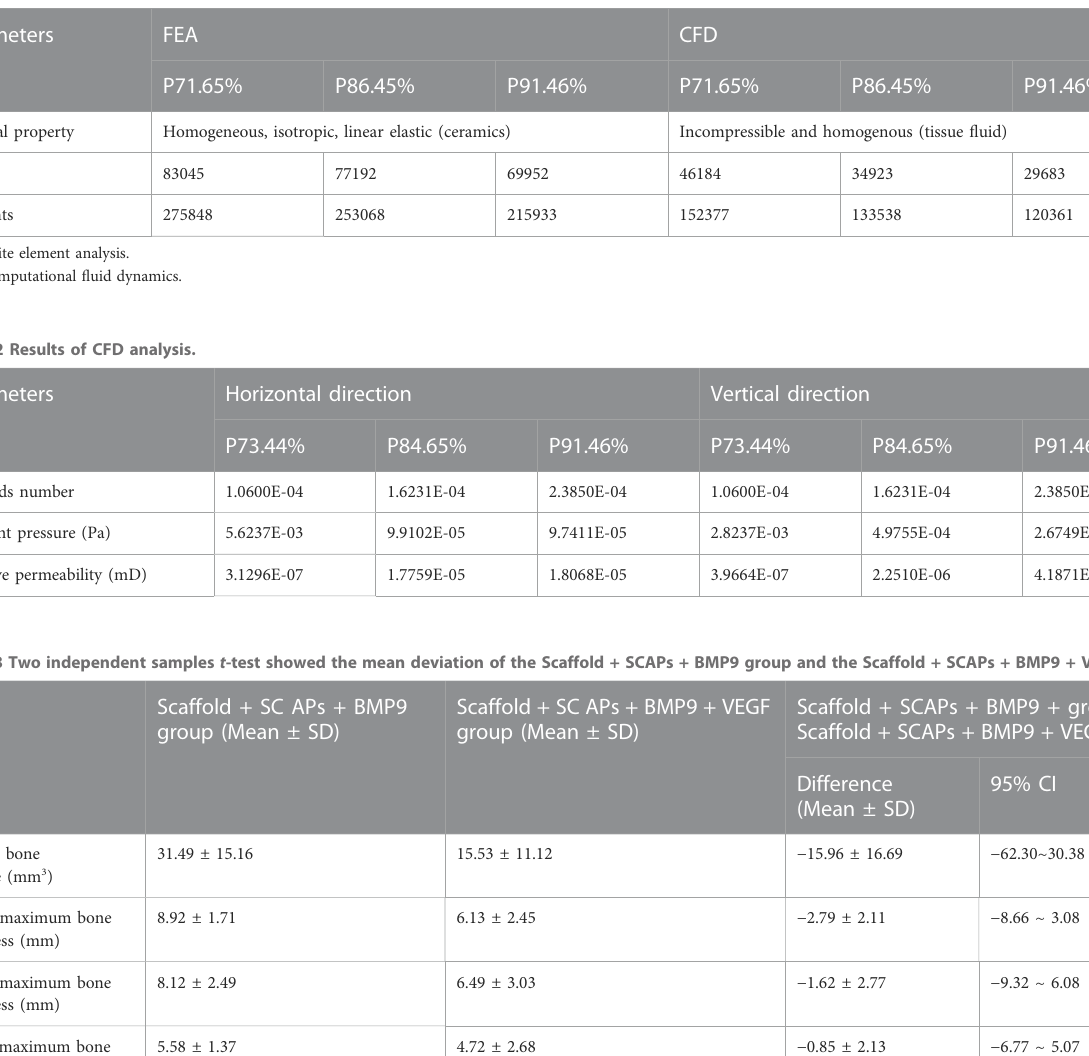
TABLE 1 Parameters of FEA and CFD simulation.